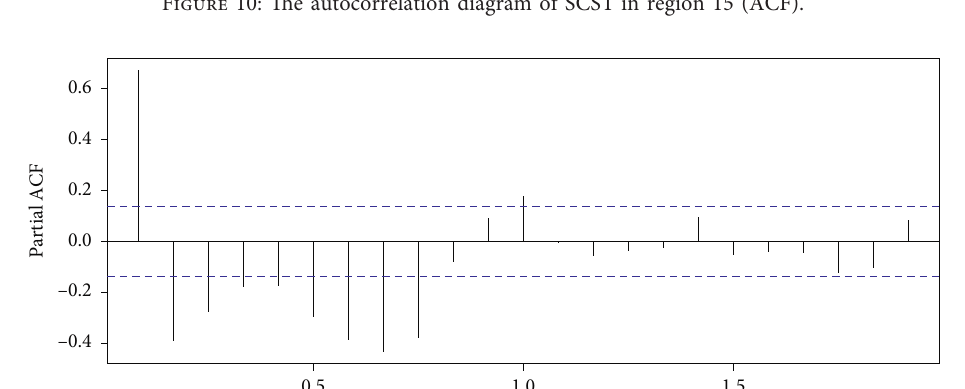
Figure 11: The partial autocorrelation diagram of SCST in region 15 (PACF).